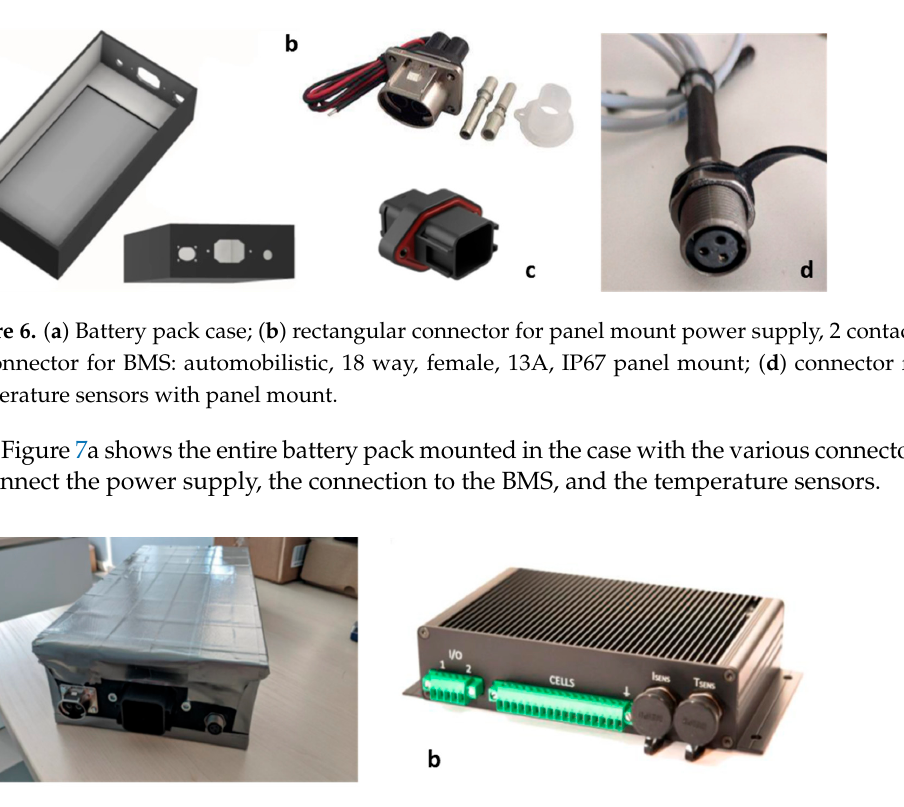
Figure 7. ( a ) Complete battery pack; ( b ) BMS REC model Q.